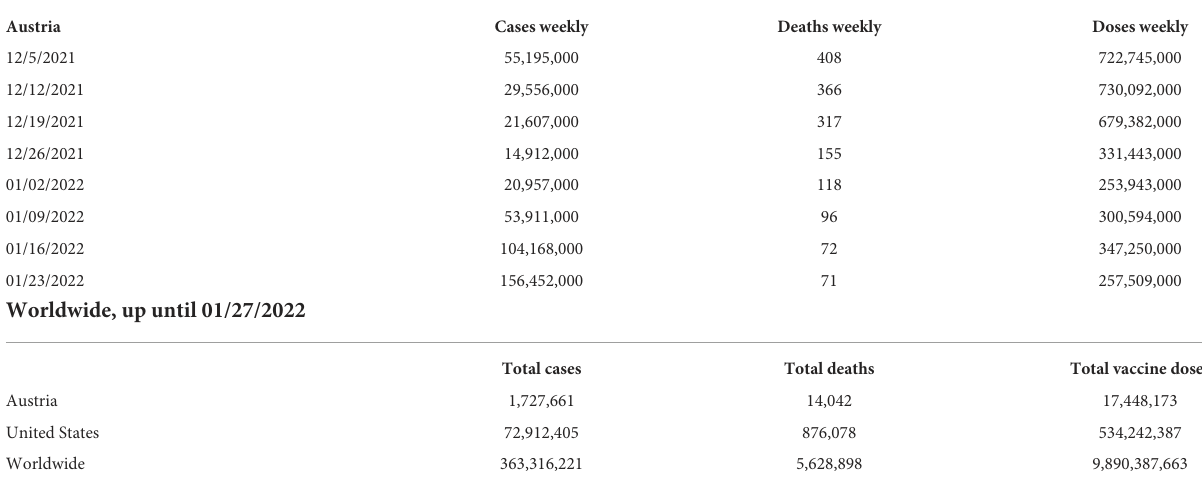
TABLE 1 COVID-19 cases, deaths and doses between November 2021 and January 2022 (10). Austria, up until 01/27/2022